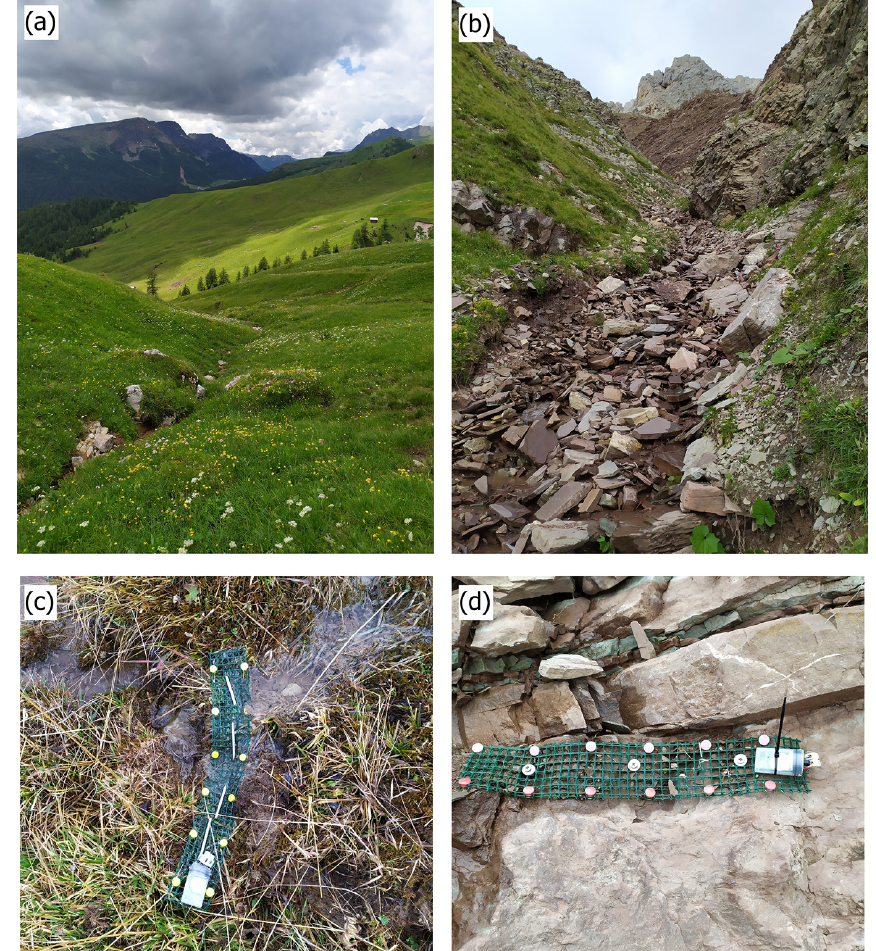
Figure 2. (a, c) Picture of Zone 1 (a) and a sensor on the grass (c) . (b, d) Picture of Zone 2 (b) and a sensor net screwed on a rock (d)